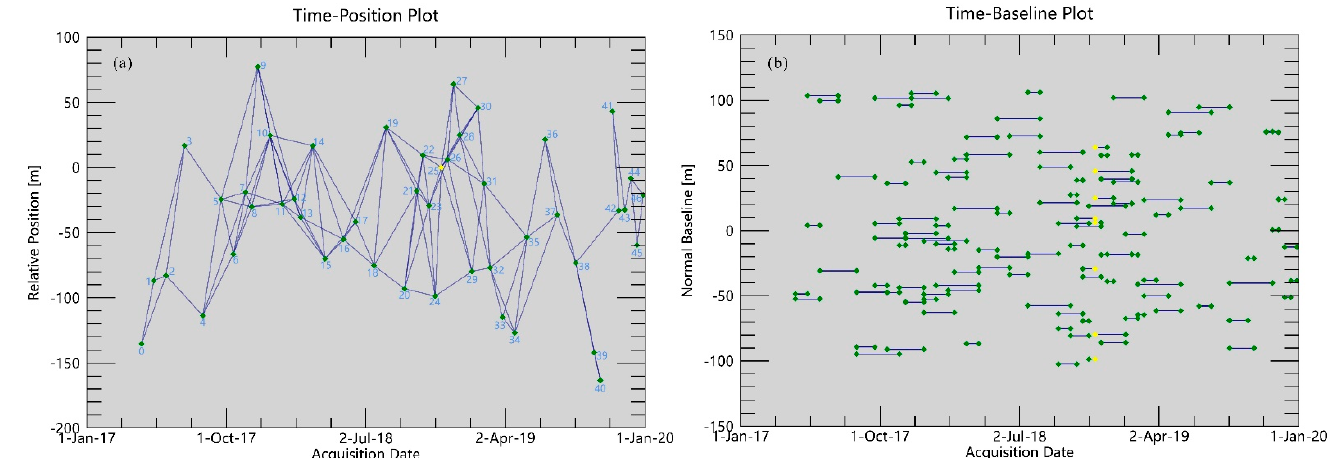
Figure 4. ( a ) Time–position plot of Sentinel-1A acquisitions; and ( b ) time–baseline plot of Sentinel-1A interferometric pairs. Each green point represents a slave image, each yellow point represents a super master image, and each line represents an interferometric pairs.